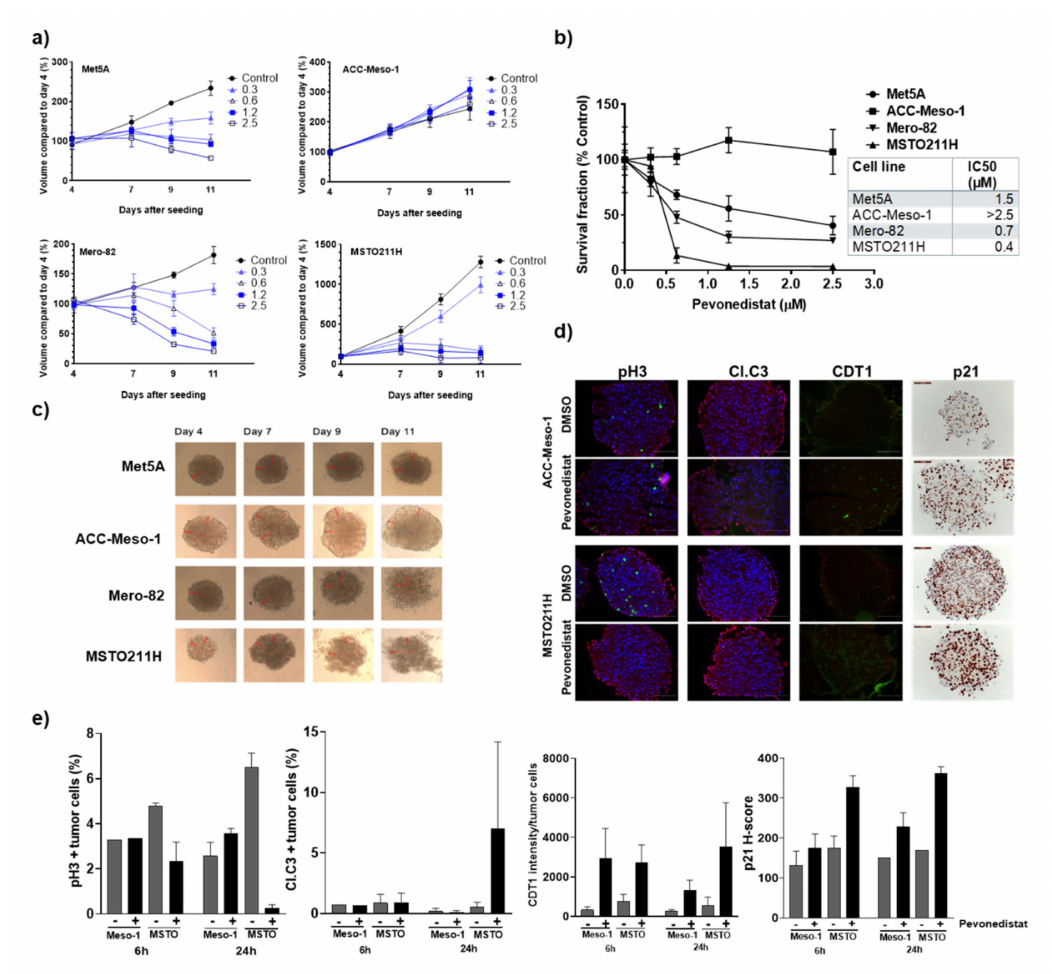
Figure 4. Response of MPM cell lines grown in 3D culture to pevonedistat. ( a ) Cells grown in multicellular spheroids were treated on day 4 and day 7 after seeding with the indicated increasing concentration of pevonedistat ( µ M). To monitor the drug e ffi cacy, we measured the spheroid volume on days 4, 7, 9 and 11. The graphs were plotted as a percentage of the sphere volume compared to day 4. Pevonedistat e ff ectively inhibited the growth of Met5A, Mero-82 and MSTO211H without a ff ecting ACC-Meso-1 at any concentration tested. ( b ) The IC 50 of pevonedistat in the inhibition of the